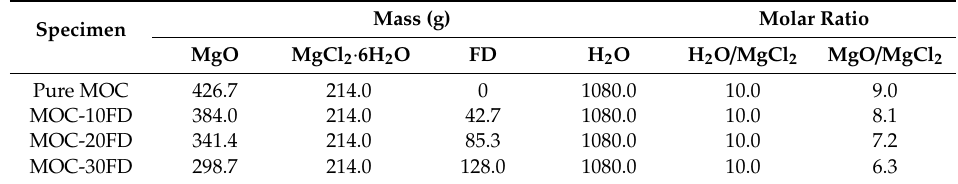
Table 1. The formulation of the FD / MOC composites with di ff erent FD